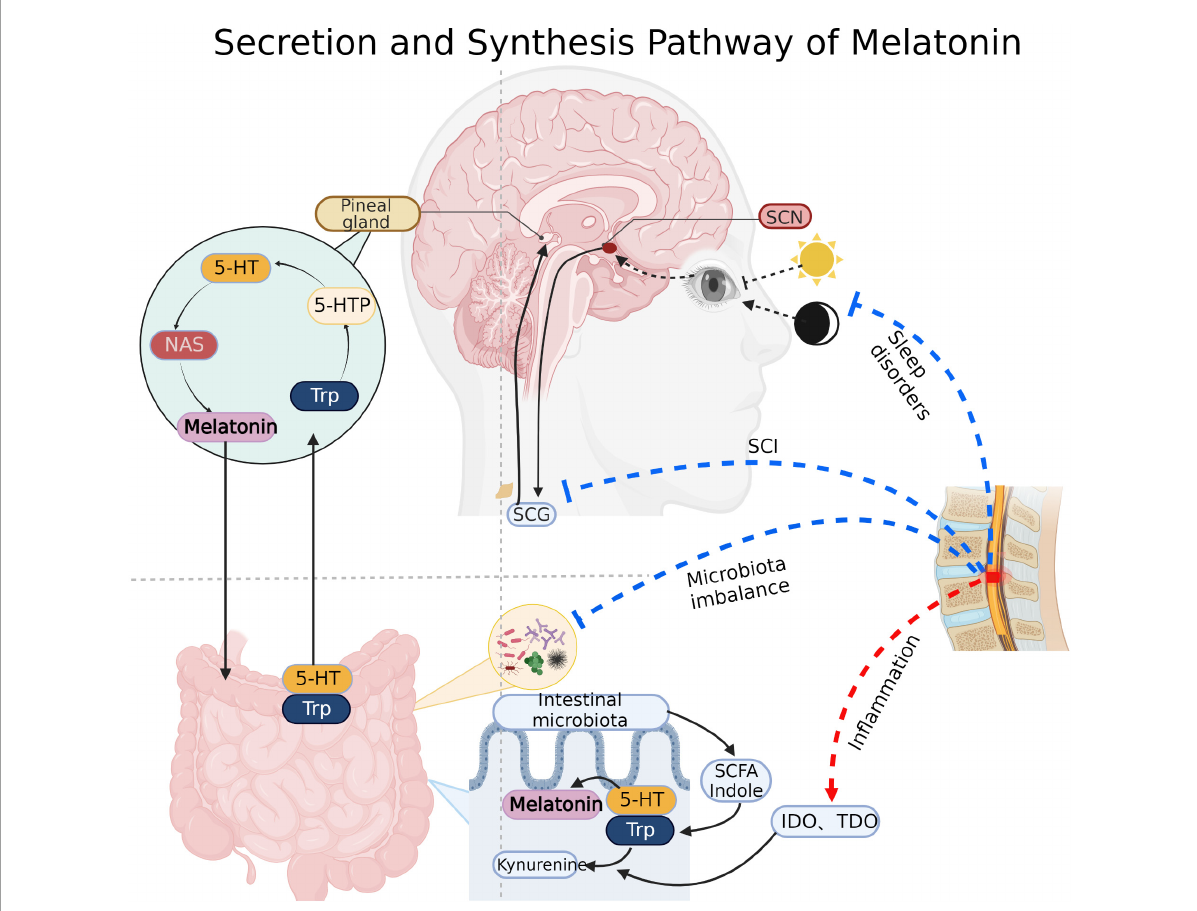
FIGURE1 Melatonin synthesis: Pineal cells absorb tryptophan (Trp) and produce melatonin through intermediates such as 5-hydroxytryptophan (5-HTP), serotonin and N-acetyl-5-hydroxytryptamine (NAS). Substances such as indole and short chain fatty acids produced by gut microbiota also promote the synthesis of gut-derived melatonin. Light signal regulation of melatonin: Light signal received by the optic apparatus transmits to the supraoptic nucleus (SCN) of the hypothalamus, then it continues to transmit to the sympathetic cervical ganglion (SCG) through the brainstem and spinal cord, and finally arrived at the pineal gland to regulate the secretion of melatonin. Spinal cord direct damage, sleep disorders, microbiota imbalance and inflammatory will inhibit the synthesis and secretion of melatonin after SCI. IDO, Indoleamine 2, 3-dioxygenase; TDO, Tryptophan dioxygenase. Created with